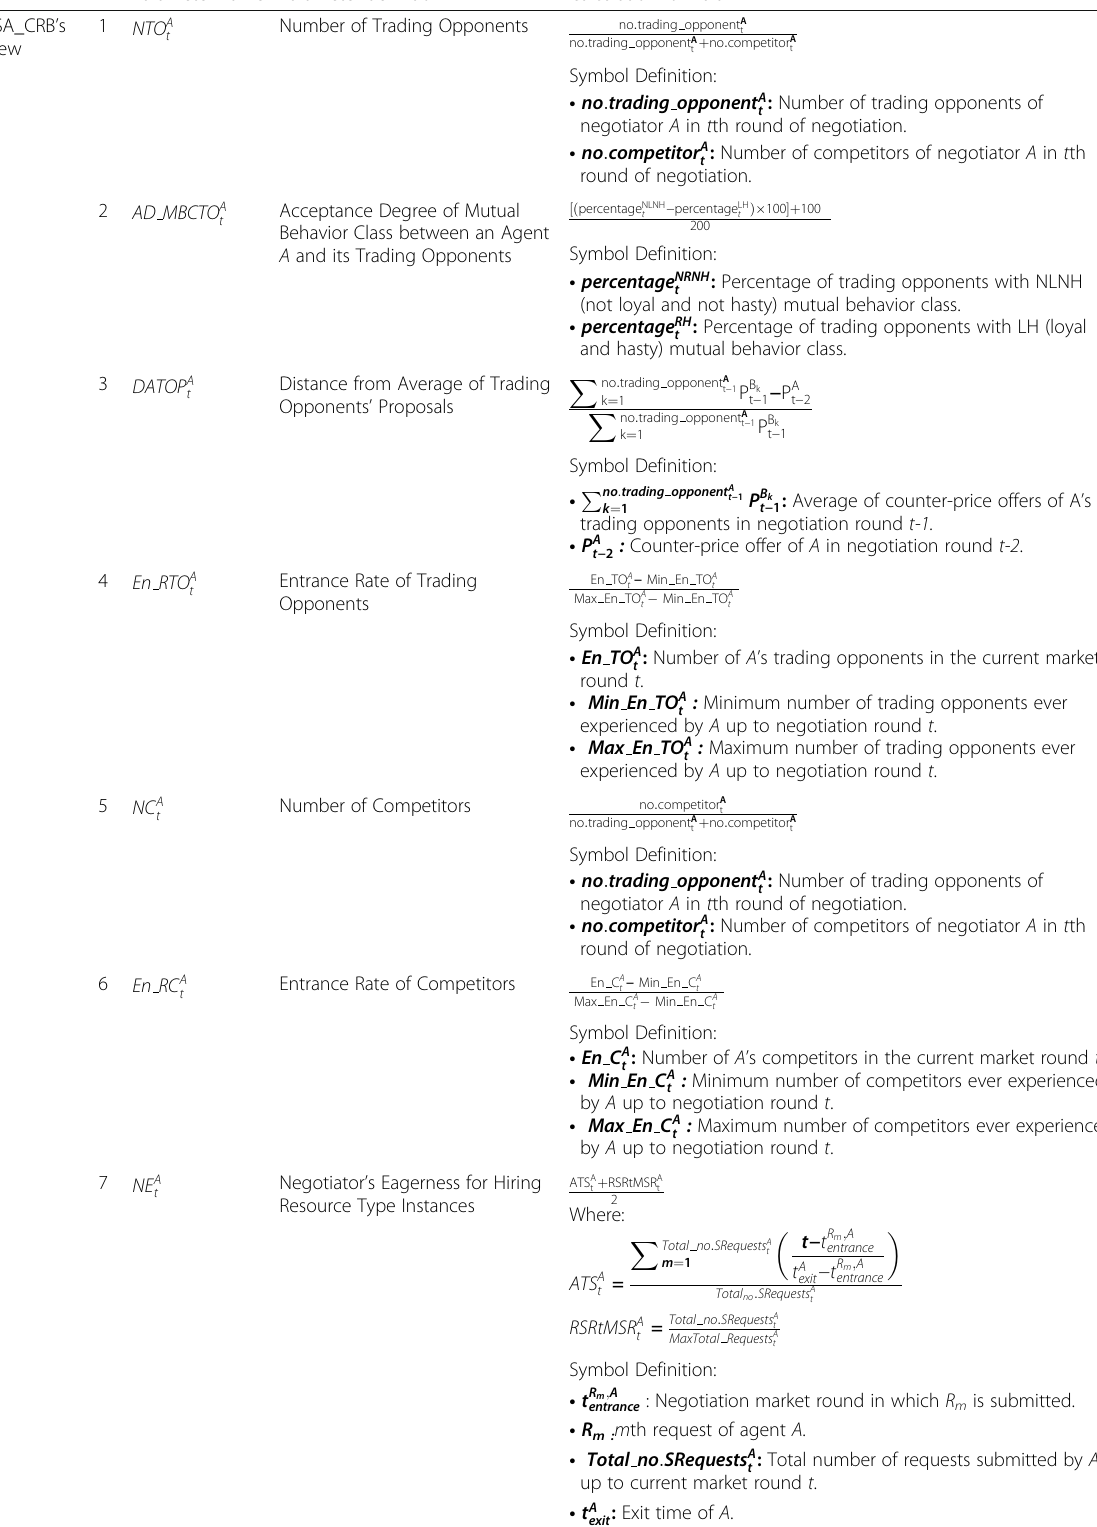
Table 1 Parameters that are used to model critical condition of the cloud trading market from both FNSSA_CRP ’ s and FNSSA_CRB ’ s points of view and their calculation